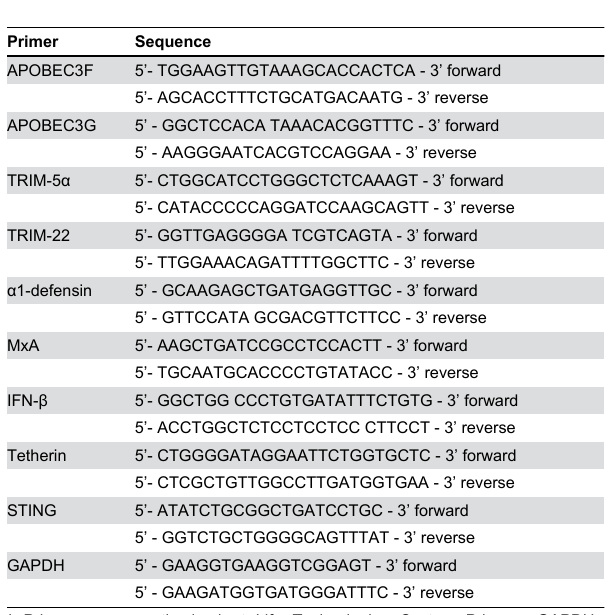
Table 1. Oligonucleotide primers used in the study for PCR